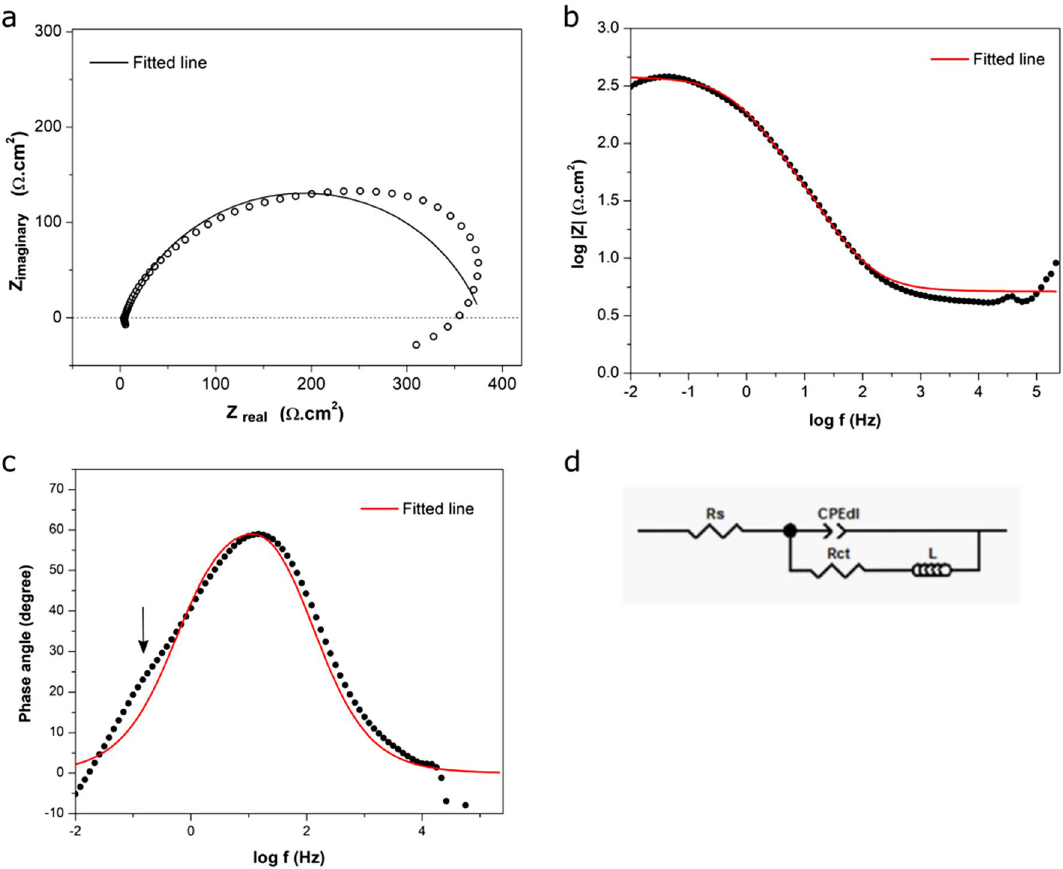
Figure 5. ( a – c ) Electrochemical impedance spectrum of uncoated mild steel in 3.5% NaCl solution ( a : Nyquist plot; b , c : Bode plots); ( d ) equivalent circuit used to simulate the spectrum; (arrow: shoulder overlapping with major